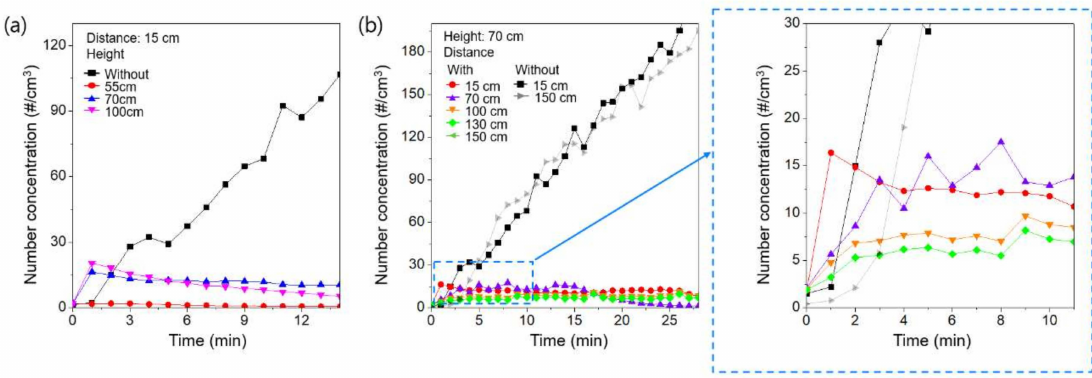
Figure 2. The change in the concentration of simulated respiratory droplet nuclei as a function of time ( a ) for various heights of the source and ( b ) for various distances between the air purifier and the